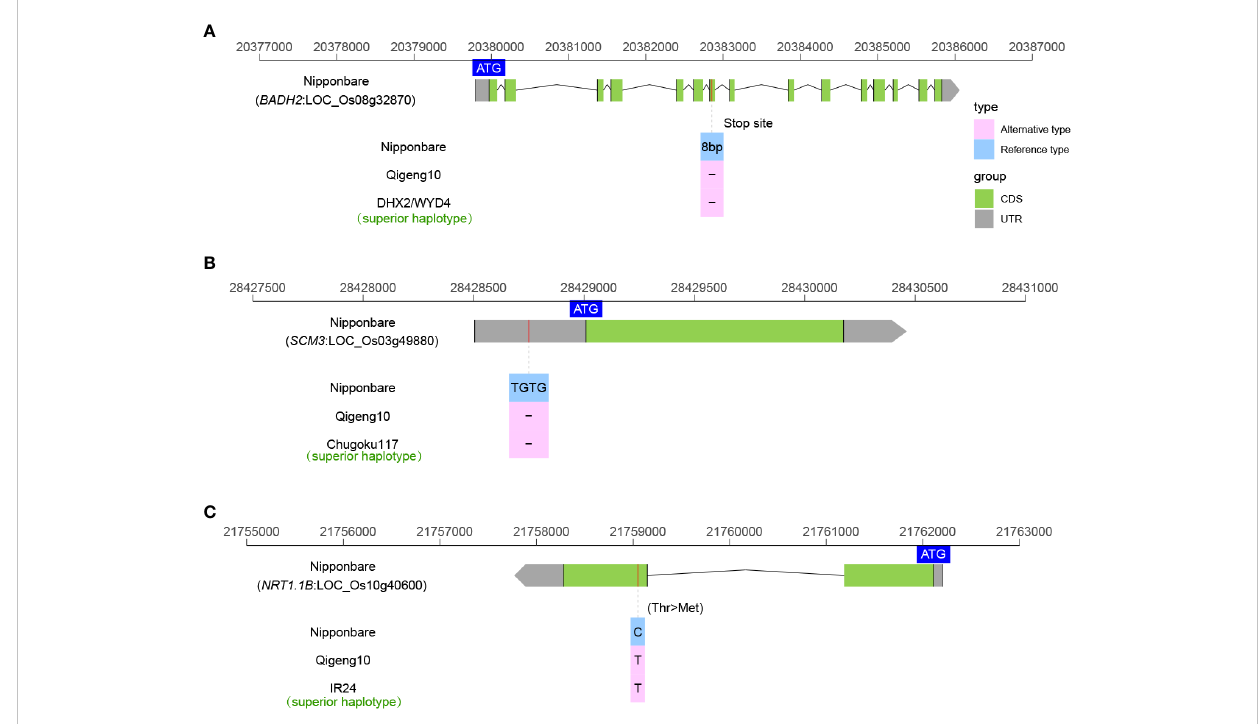
FIGURE 7 The allelic sequence variants of BADH2 (A) , SCM3 (B) , and NRT1.1B (C) in